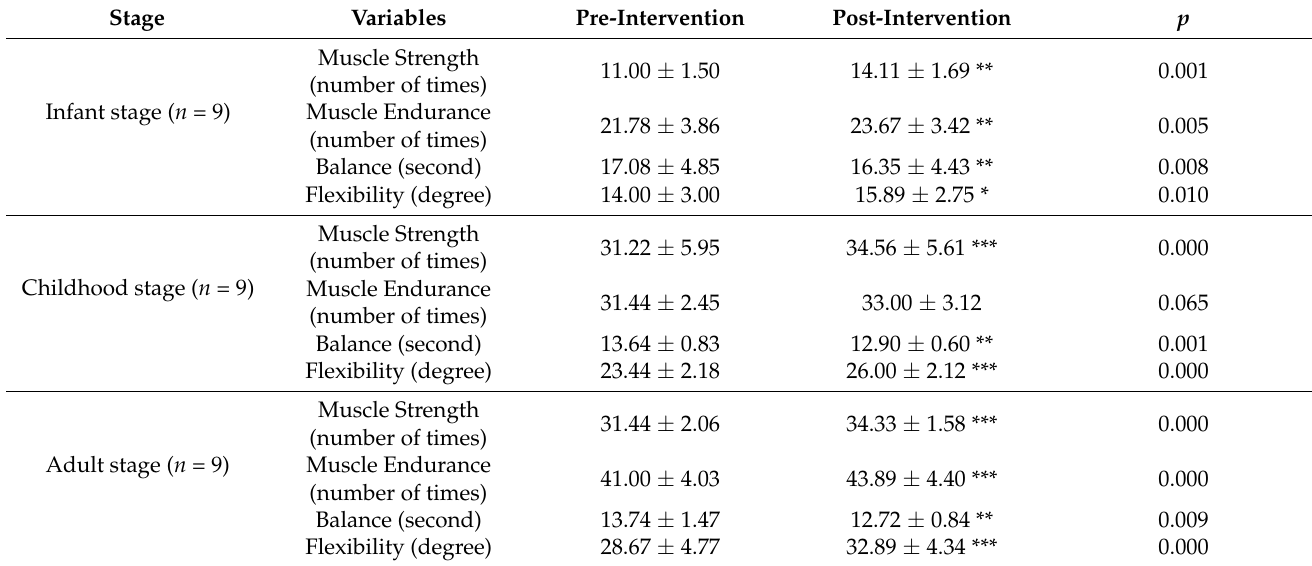
Table 3. Differences before and after the augmented reality-based intervention in each group.